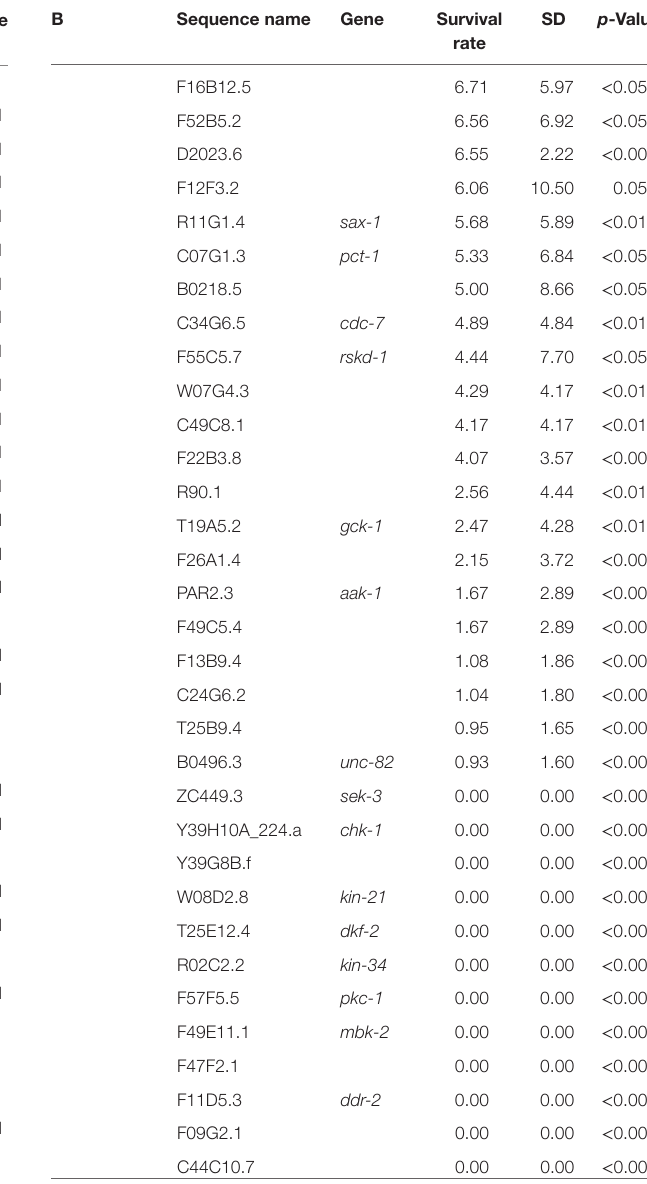
TaBle 1 | Excerpt from the kinome RNAi